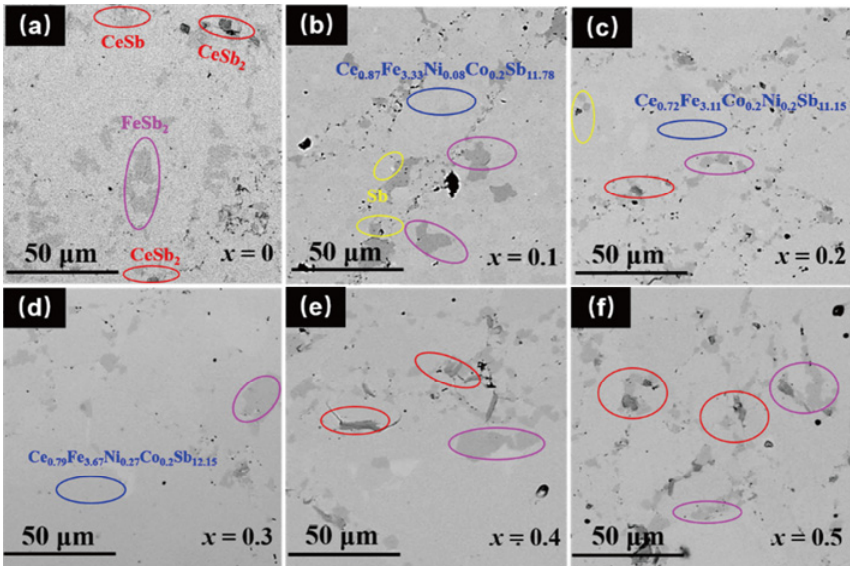
Fig. 4 BEIs of polished CeFe 3.8 − x Ni x Co 0.2 Sb 12 ( x = 0, 0.1, 0.2, 0.3, 0.4, and 0.5) samples: (a) x = 0, (b) x = 0.1, (c) x = 0.2, (d) x = 0.3, (e) x = 0.4, and (f) x = 0.5.